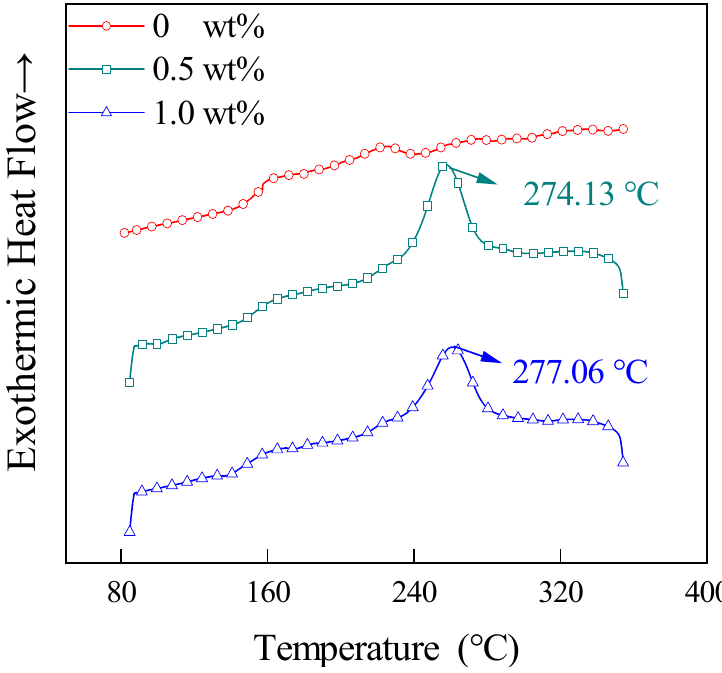
Figure 9. The DSC cooling curves of composites with different CNT contents. Table 1. T cc , T m , T c , Δ H m , Δ H cc , Χ c and t 1/2 of prepregs with different CNT contents.